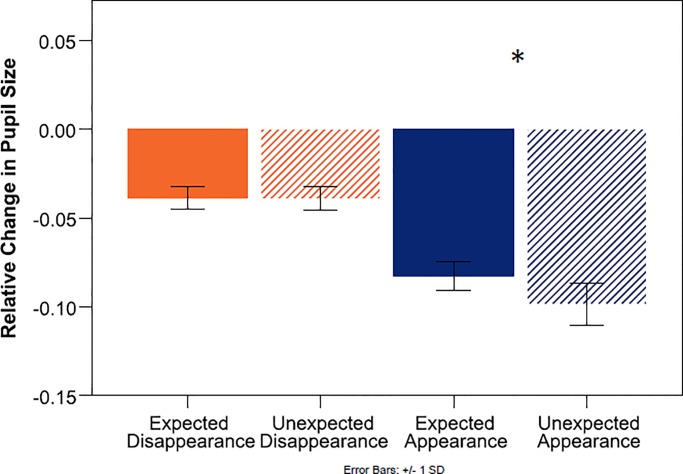
Mean change in pupil size relative to baseline in 10-months-olds.Note that a smaller negative deviation from zero denotes a larger pupil.